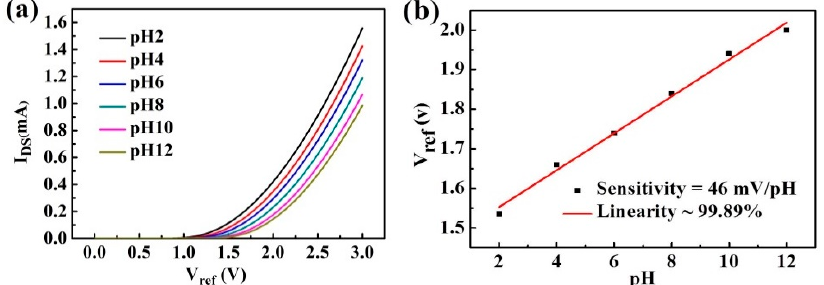
Figure 5. ( a ) I DS -versus- V ref curve under various pH buffer solutions. ( b ) Linearity of the V ref of TiO 2 EGFET sensor.